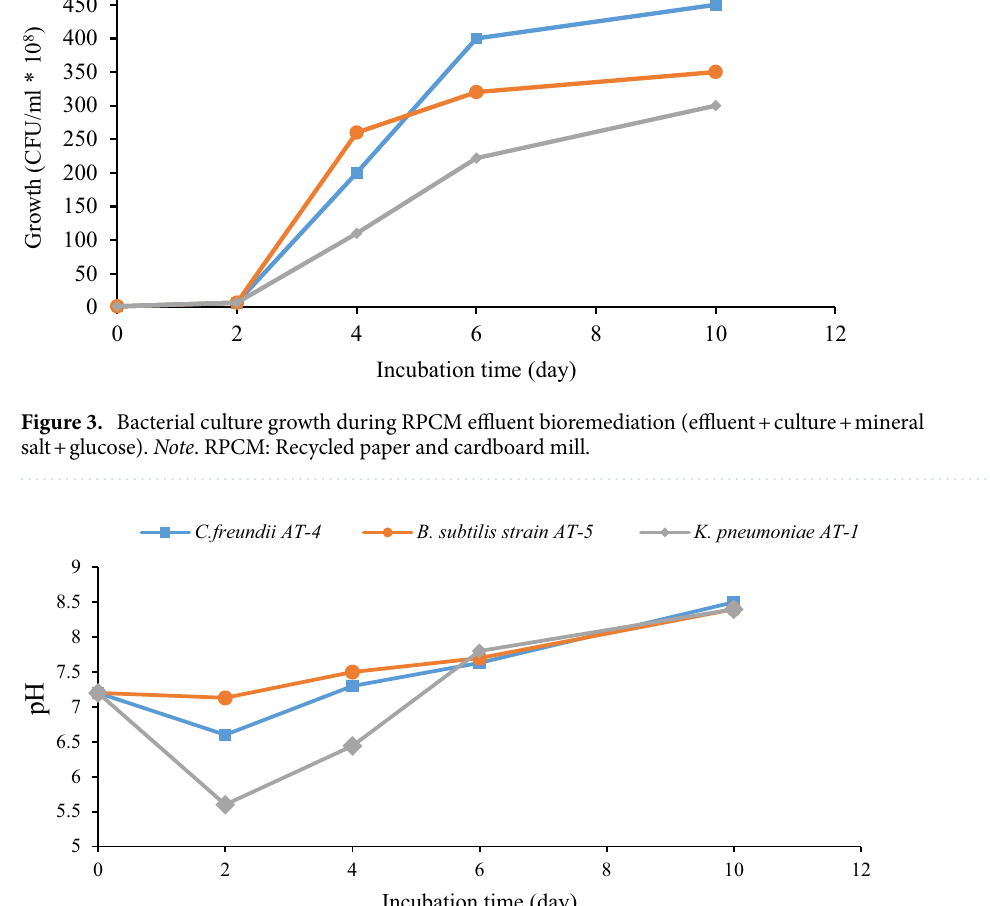
Fig. 6. Based on the results, the biodegradation of COD and color by the B. subtilis strain AT-5 after a 10-day incubation period was 35.8 ± 6.16% and 27.53 ± 3.96%, respectively. The biodegradation of COD and color by K. pneumoniae AT-1 and C. freundii AT-4 were 31.21 ± 4.3% and 24.8 ± 2.87%, as well as 30 ± 5.39% and 24.47 ± 3.1%, respectively. According to the results of the first setup without adding the co-substrate, the removal of COD and color by the B. subtilis strain AT-5 was higher compared to the other strains. These results indicate that K. pneumoniae AT-1 and C. freundii AT-4 strains can also degrade some of COD and color without using the co-